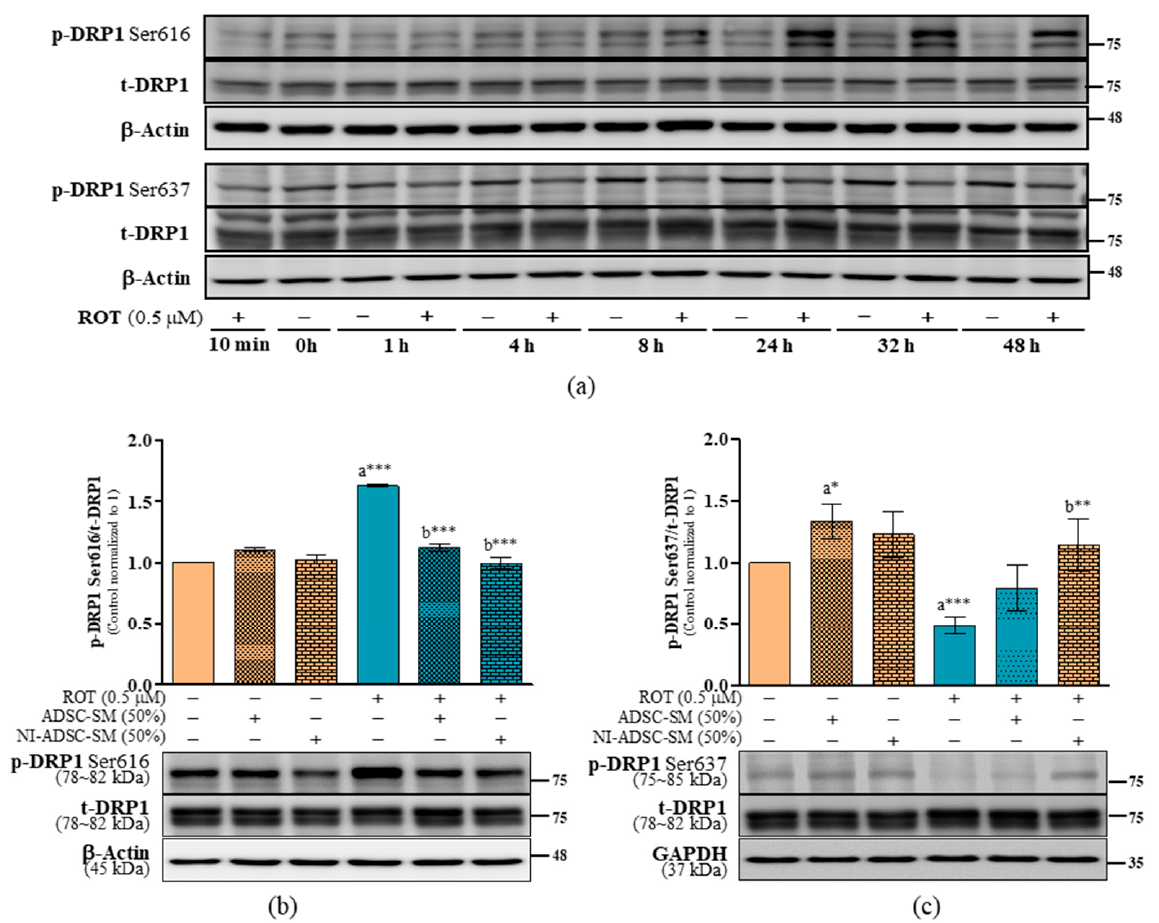
Figure 6. Effects of the NI-ADSC-SM on mitochondrial fission-associated proteins. Cells treated with or without ROT (0.5 µ M) at different timepoints were assessed for DPR1 protein expression by Western blotting ( a ). Cells were incubated in the presence of ROT (0.5 µ M) or DMSO for 48 h alone or with ADSC-SM or NI-ADSC-SM (each diluted by 50%) during the last 24 h. The levels of p-DRP1 Ser616/t-DRP1 ( b ) and p-DRP1 Ser637/t-DRP1 ( c ) protein expression were assessed by Western blotting. Data are shown as the means (bars) and SEM (error bars) of three independent cell culture experiments. Statistical analysis was performed using one-way ANOVA with Tukey’s post-test. Statistical comparisons: a—compared with control; b—compared with ROT; * p < 0.05, ** p < 0.01, and *** p < 0.001. p-, phosphorylated; t-, total.